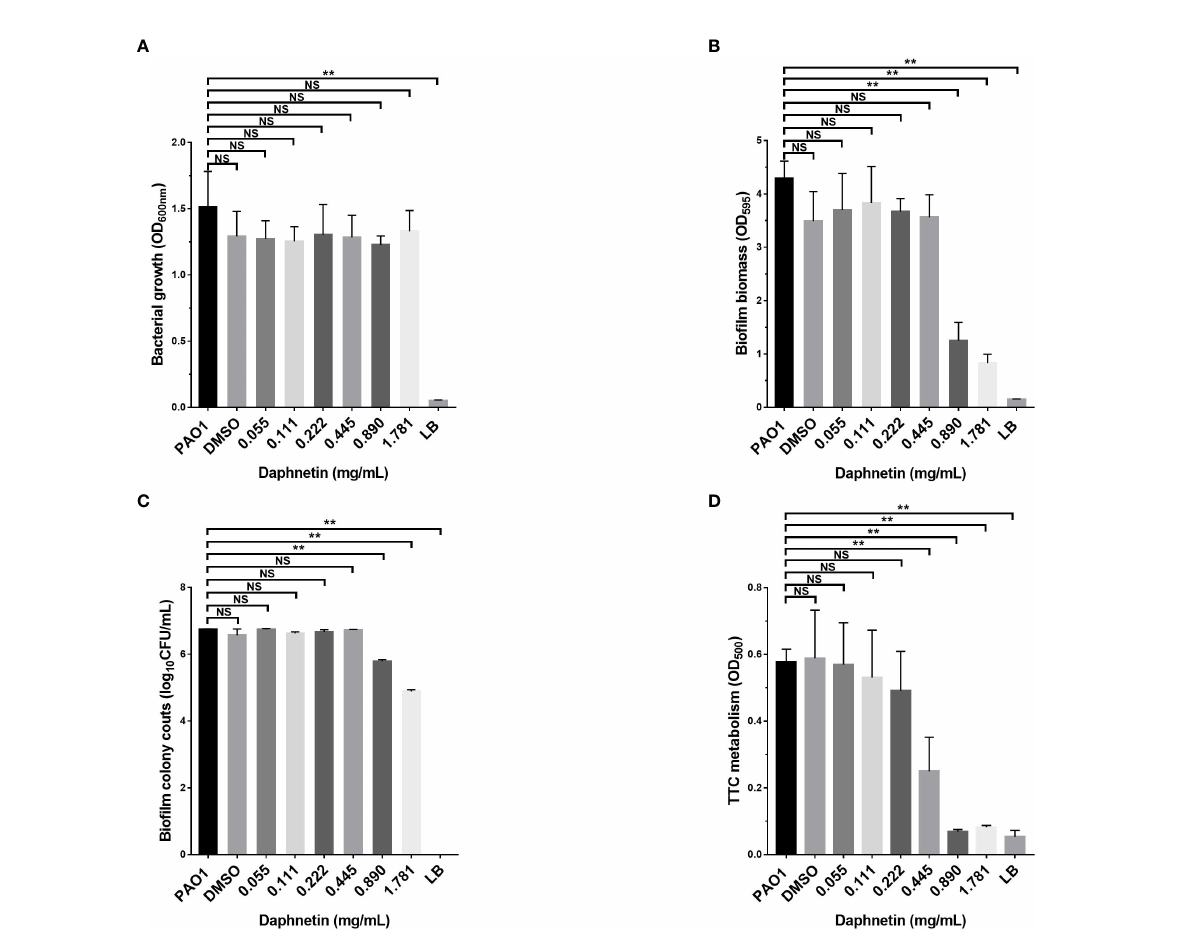
FIGURE 4 The bio fi lm eradication effect of daphnetin (DAP) against P. aeruginosa . Bio fi lms of P. aeruginosa were formed in 96-well plates after 24 h culture, and the pre-formed bio fi lms were treated with different concentrations of DAP (0.055, 0.111, 0.222, 0.445, 0.890, and 1.781 mg/mL) for 20 h. The bio fi lm mass, bacterial counts, bacterial metabolism, and bio fi lm biomass before treatment were quanti fi ed in triplicate. (A) Bio fi lm formation before treatment. (B) Crystal violet staining. (C) Bio fi lm bacterial counts. (D) TTC staining. Results are represented as the mean ± SD; NS indicates P-values >0.05 and ** indicate P-values